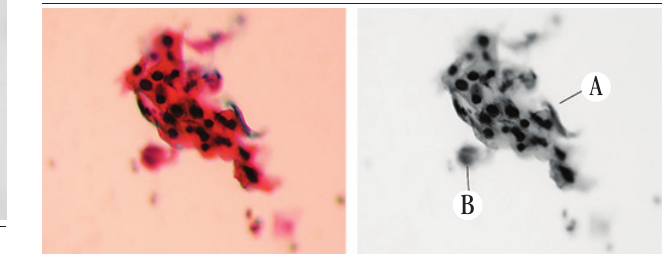
figuRE 4 − High-grade anal lesion (Papanicolaou stain, 40×), clear background A) cluster of atypical parakeratotic cells; binucleated cell with dense eosinophilic cytoplasm, elongated in shape; B) altered nucleus/cytoplasm ratio, hyperchromatic nuclei with irregular borders, granular chromatin.